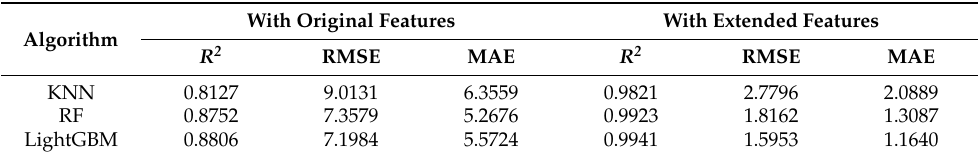
Figure 5. Comparison chart of machine learning model results. ( a ) Original features are used as input; ( b ) extended features are used as input. Table 3. Performance of three machine-learning models on the dataset. Algorithm